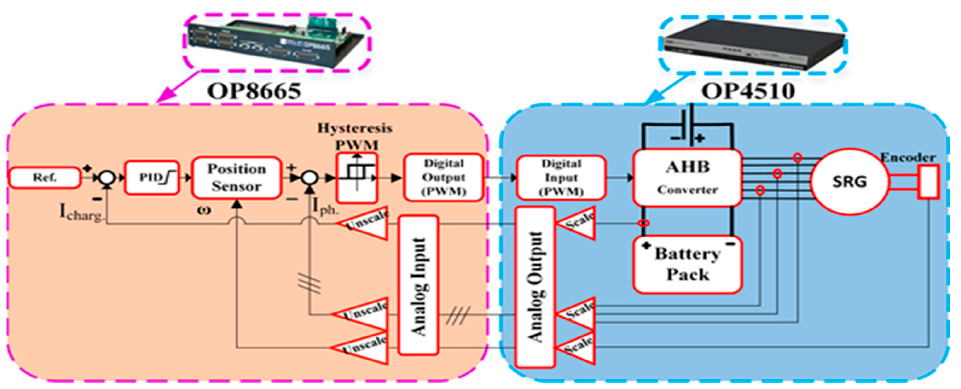
Figure 19. Block diagram of the (ChiL) process.